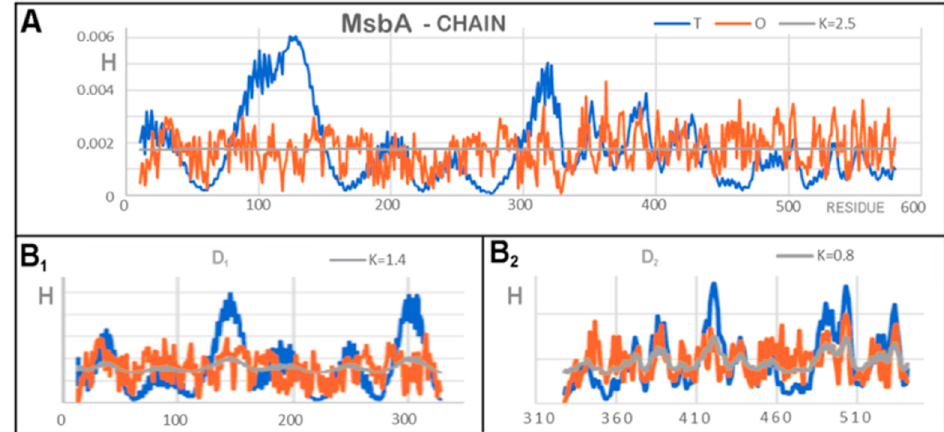
Figure 9. A set of T, O, and M profiles for 6UZL for a single chain and domains treated as individual structural units. ( A ) Chain A. ( B ) Domains ( B1 ) D1, ( B2 ) D2.